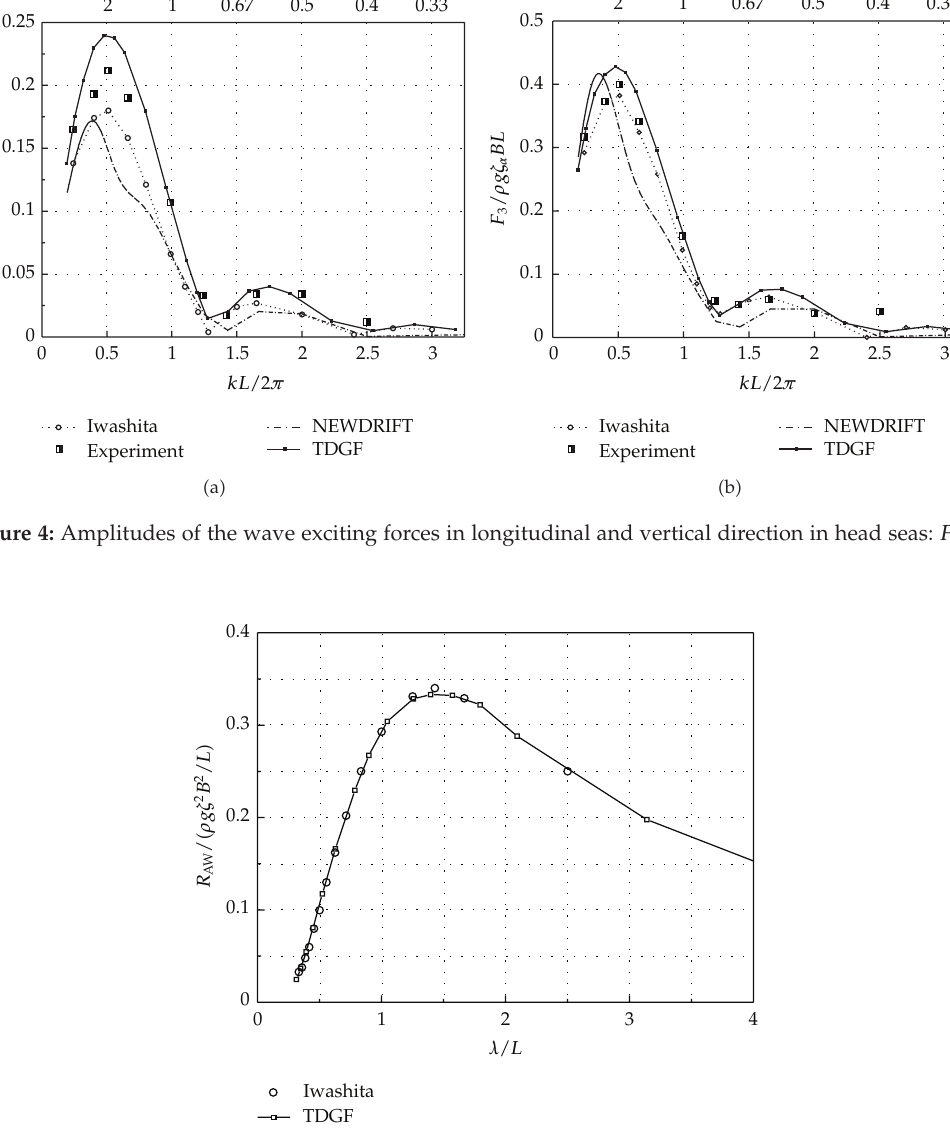
Figure 5: Di ff raction-added resistance: F n (cid:7) 0 .